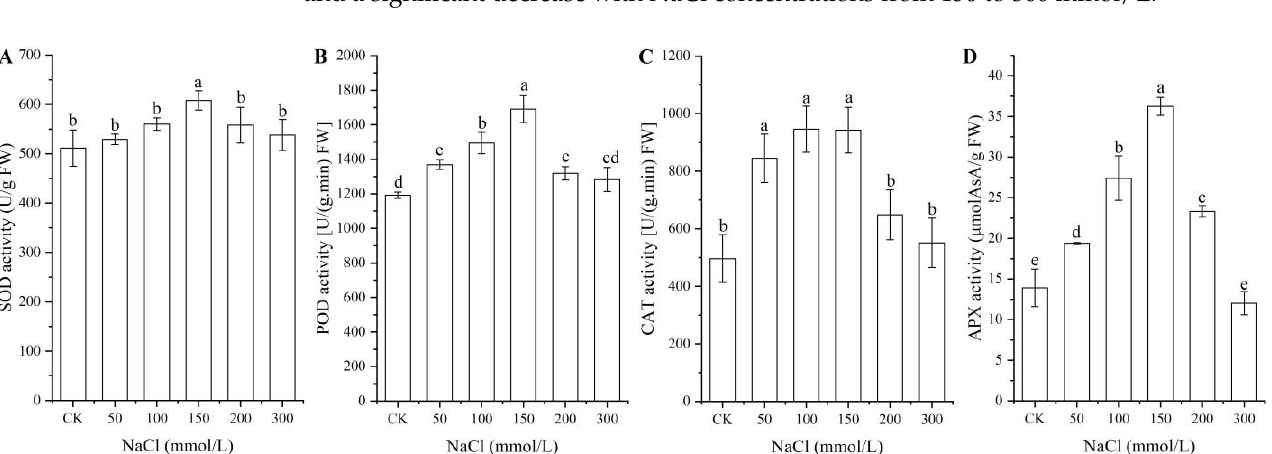
Figure 1. Change in the seed germination rate of Apocynum venetum under different NaCl treatments. Different letters represent a significant difference ( p < 0.05) among different NaCl treatments.